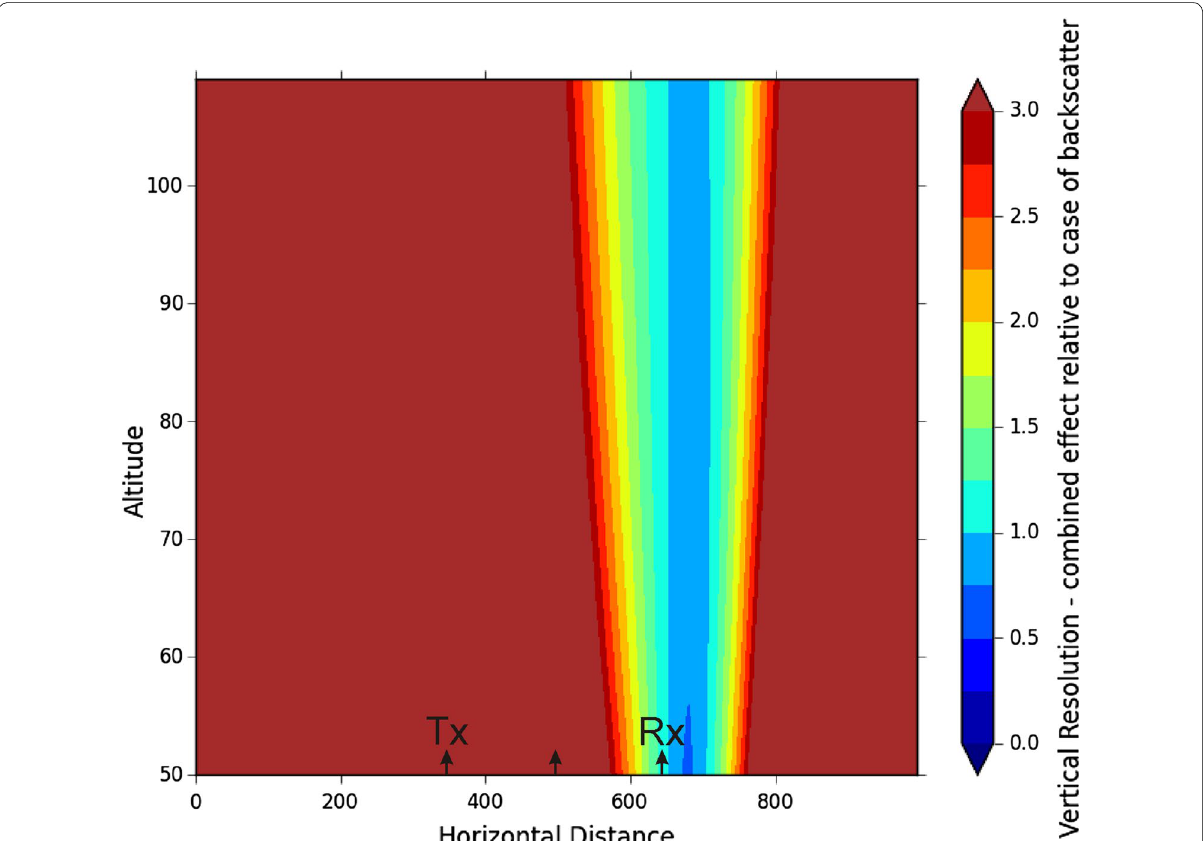
Fig. 4 Vertical resolution of the system relative to the “vertical backscatter resolution”. Only the data between 75 and 110 km altitude are of interest here. See text for